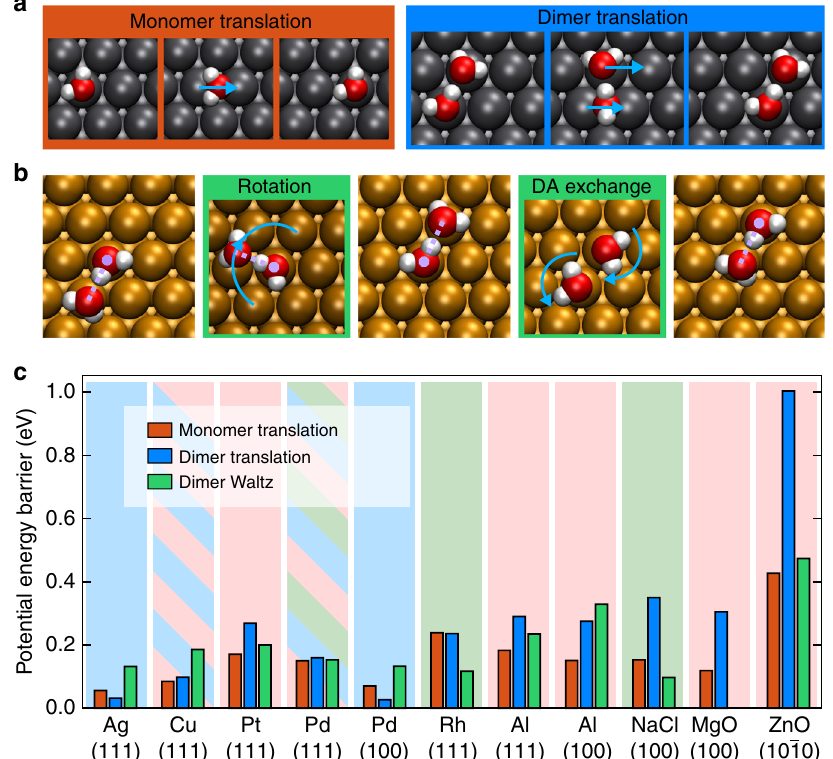
Fig. 1 Water monomer and dimer diffusion mechanisms and barriers on a range of solid surfaces. a Top view of the water monomer and dimer translational diffusion pathway on Pd(111). b Top view of water dimer waltzing diffusion on an FCC(111) metal surface, showing the rotation and DA exchange steps. The violet dotted lines indicate the H-bonds in the dimer, with the large dot marking the H-bond donor. c Potential energy barriers for water monomer diffusion, dimer translation, and dimer waltzing diffusion on all the common surfaces studied. The background colour indicates the lowest barrier diffusion pathway on each surface, red: monomer diffusion; blue: dimer translation; green: dimer waltz. Multiple colours means that there are competing favourable diffusion mechanisms with barriers within 10 meV. All the barrier values are provided in the supporting information